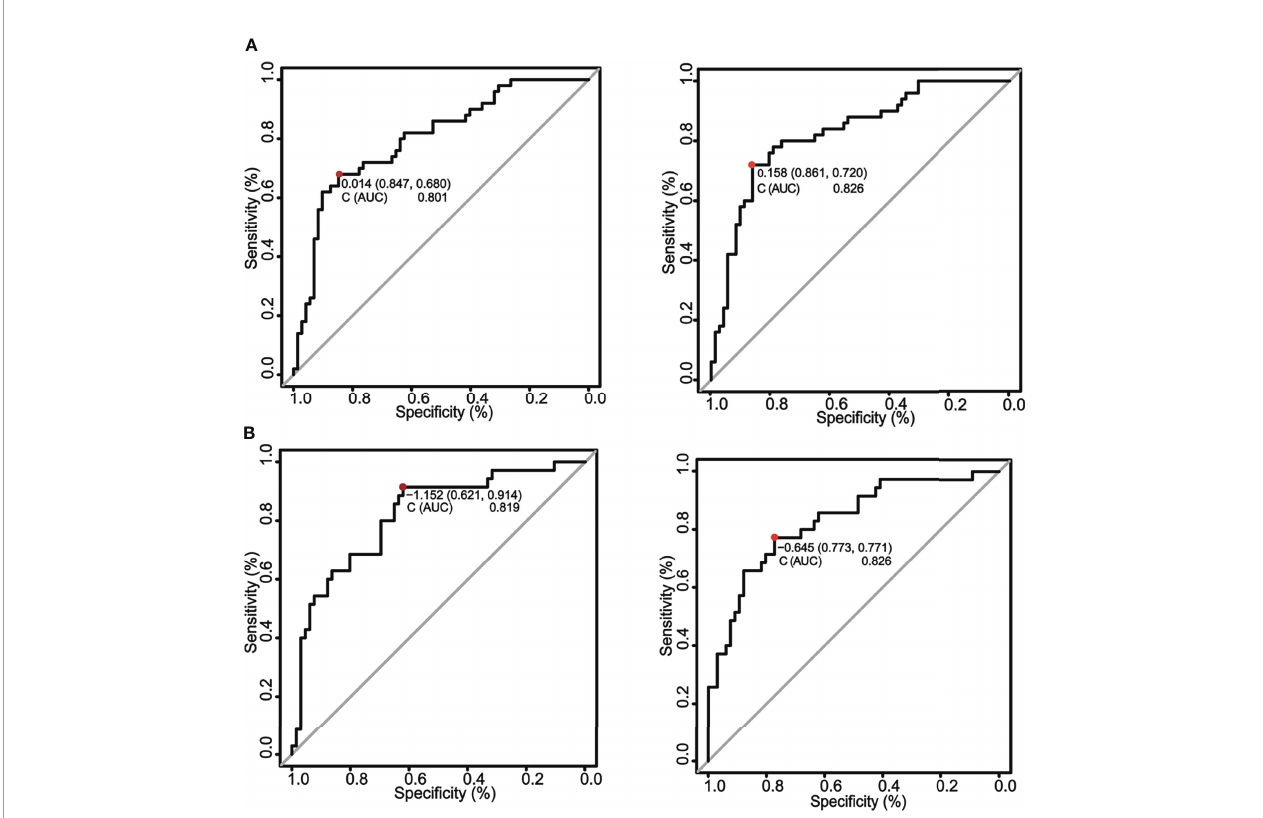
FIGURE 6 | A comparison of ROC curves for the nomograms in training and validation cohorts. (A) ROC curves of nomograms in training cohorts. The ROC curves of nomograms with the four risk factors alone (left panel) and an incorporation of MMP-3 in the four risk factors (right panel) in the training cohorts, respectively. The C index of the nomogram generated with the four risk factors alone was 0.801, while the C index of the MMP-3-incorporated nomogram was 0.826. The incorporation of plasma MMP-3 increased the identifying probability of nomogram for ILD in RA patients. (B) ROC curves of nomograms in validation cohorts. The ROC curves of nomograms with the four risk factors alone (left panel) and the four factors incorporated with plasma MMP-3 (right panel) in validation cohorts, respectively. The C index of the nomogram generated with the four risk factors alone was 0.819, while the C index of the MMP-3-incorporated nomogram was 0.826. An incorporation of plasma MMP-3 increased the identifying probability of nomogram for the risk of development of ILD in RA